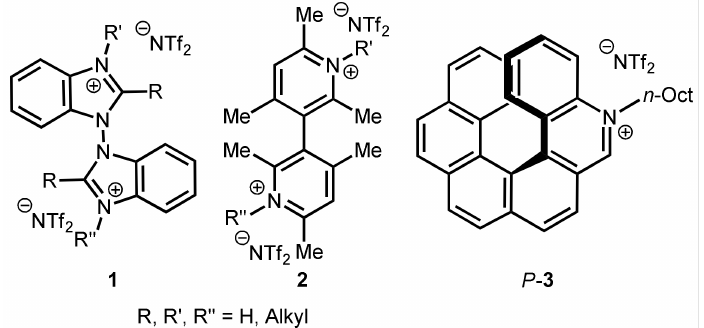
Figure 1. bi-benzimidazolium ( 1 ), bicollidinium ( 2 ) and ( P )-aza[6]helicenium bistriflimidate ( 3 )